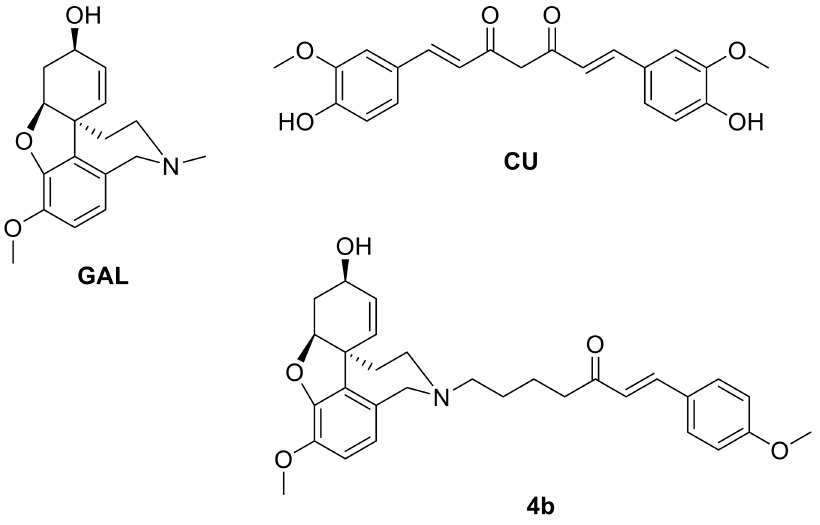
Figure 1. Structures of galantamine (GAL), curcumin (CU) and their hybrid 4b . The oxidative stress hypothesis in AD dates back to the late 1990s [7,8].